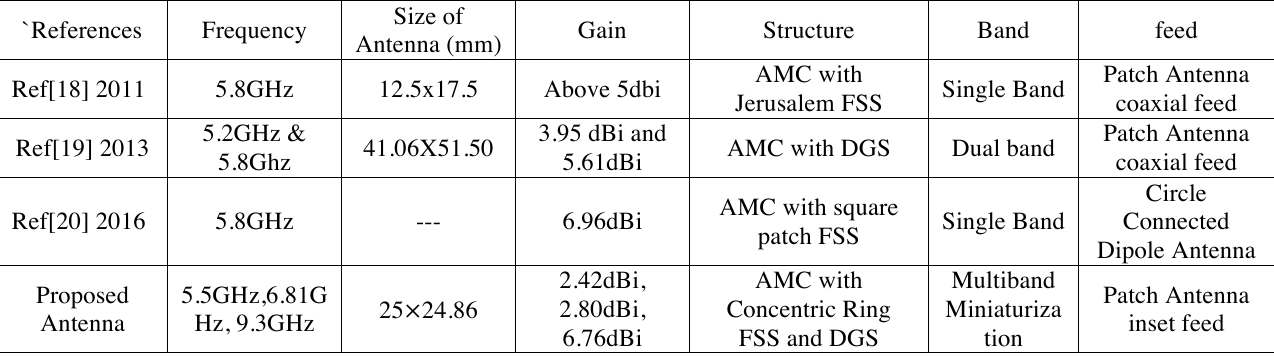
Table 3:Comparison Table with published model